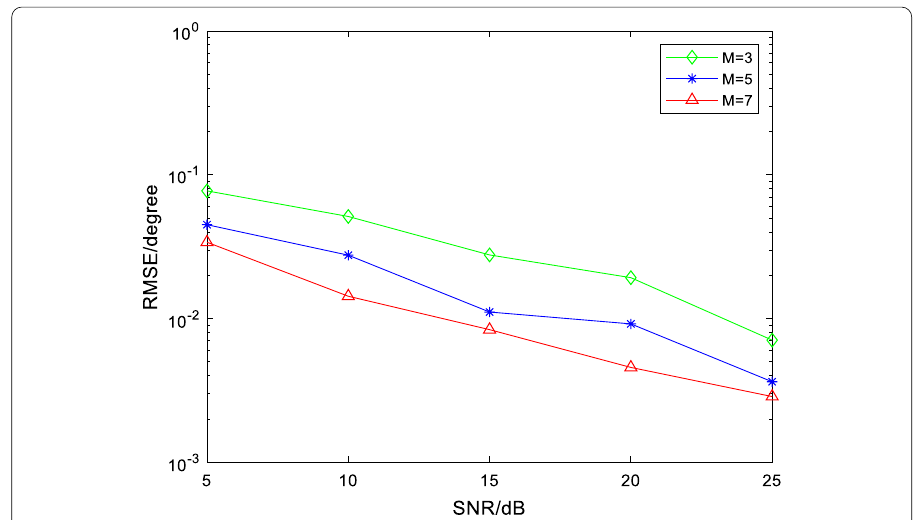
Fig. 9 Performance comparison of NRC-MIMO MUSIC algorithm with different numbers of transmitting array elements